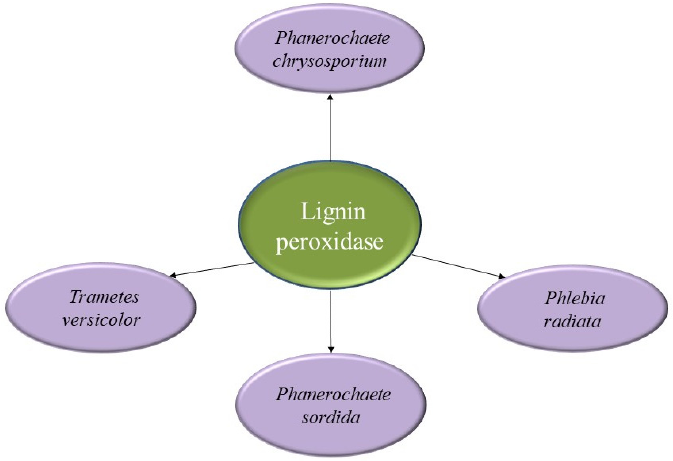
Figure 14. Some of the fungi that secrete lignin peroxidase for lignin degradation.